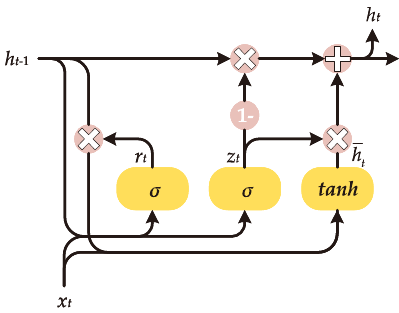
Figure 1. The structure of the gated recurrent unit network (GRU).